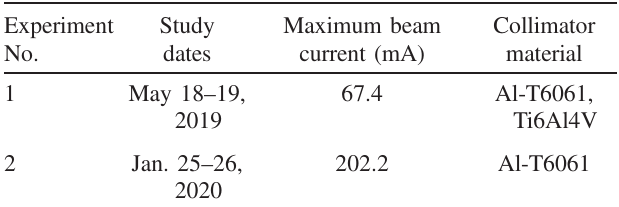
TABLE I. APS SR collimator experiments for APS-U.